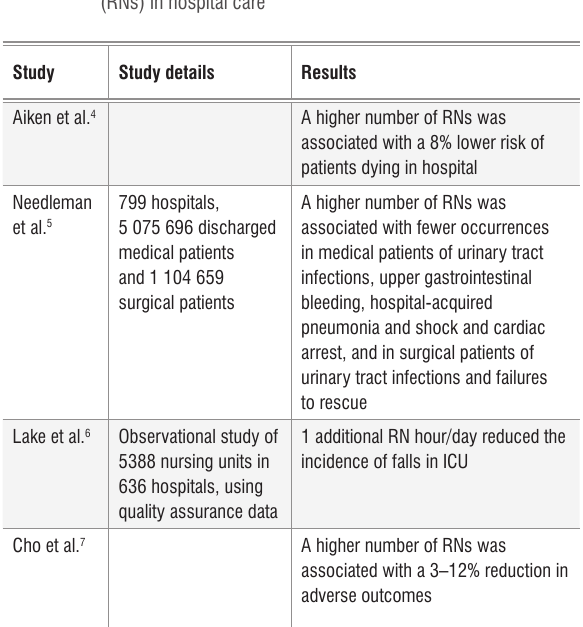
Studies investigating higher numbers of registered nurses (RNs) in hospital care